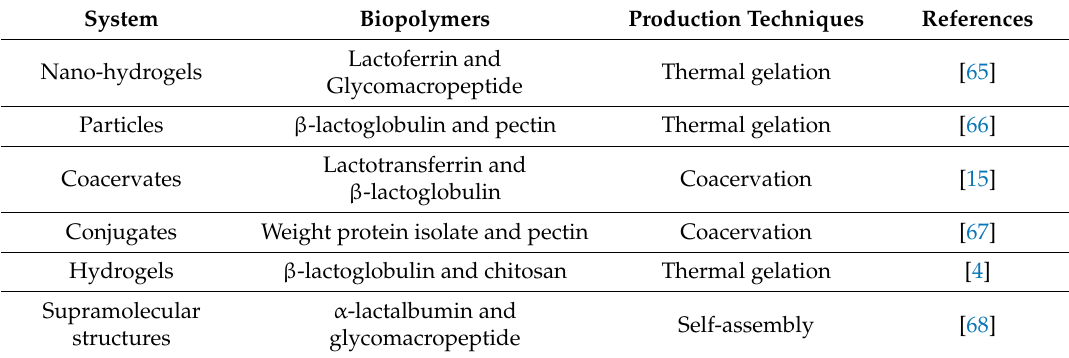
Table 2. Micro- and nanostructures produced by the combination of proteins and other biopolymers.